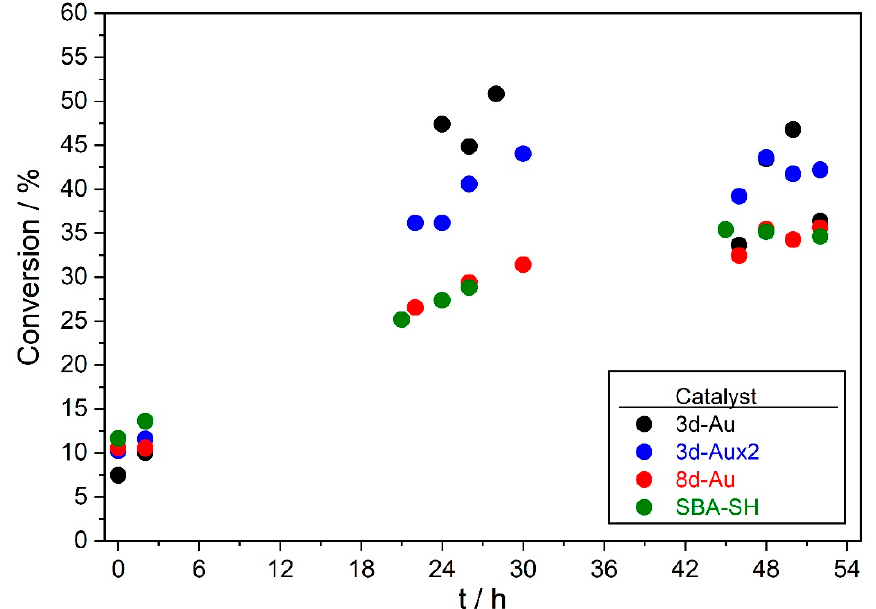
Figure 6. Cyclohexene conversion as a function of the reaction time for the catalytic experiments carried out at ambient lighting in the presence of TBHP. The experimental conditions are described in Section 2.4 of the Materials and Methods